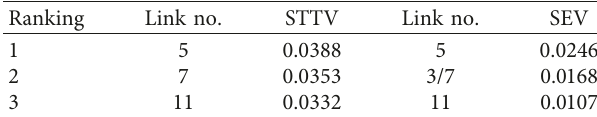
Table 11: The three most vulnerable links for partial closure. Ranking Link no.